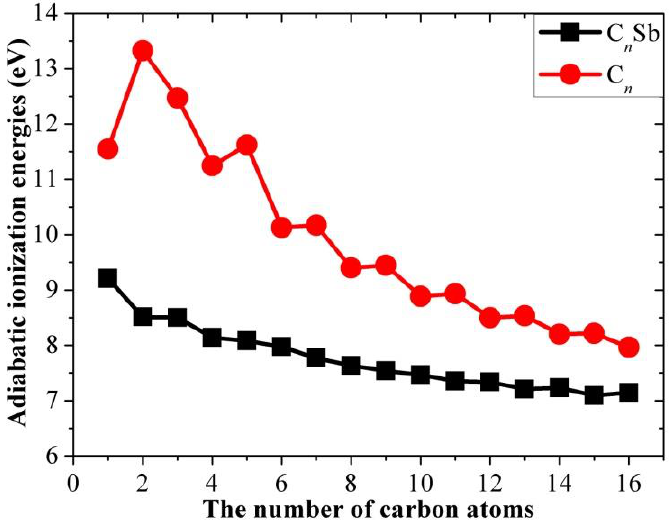
Figure 8. Adiabatic ionization energies of neutral C n Sb and pure carbon clusters C n as a function of the number of carbons.